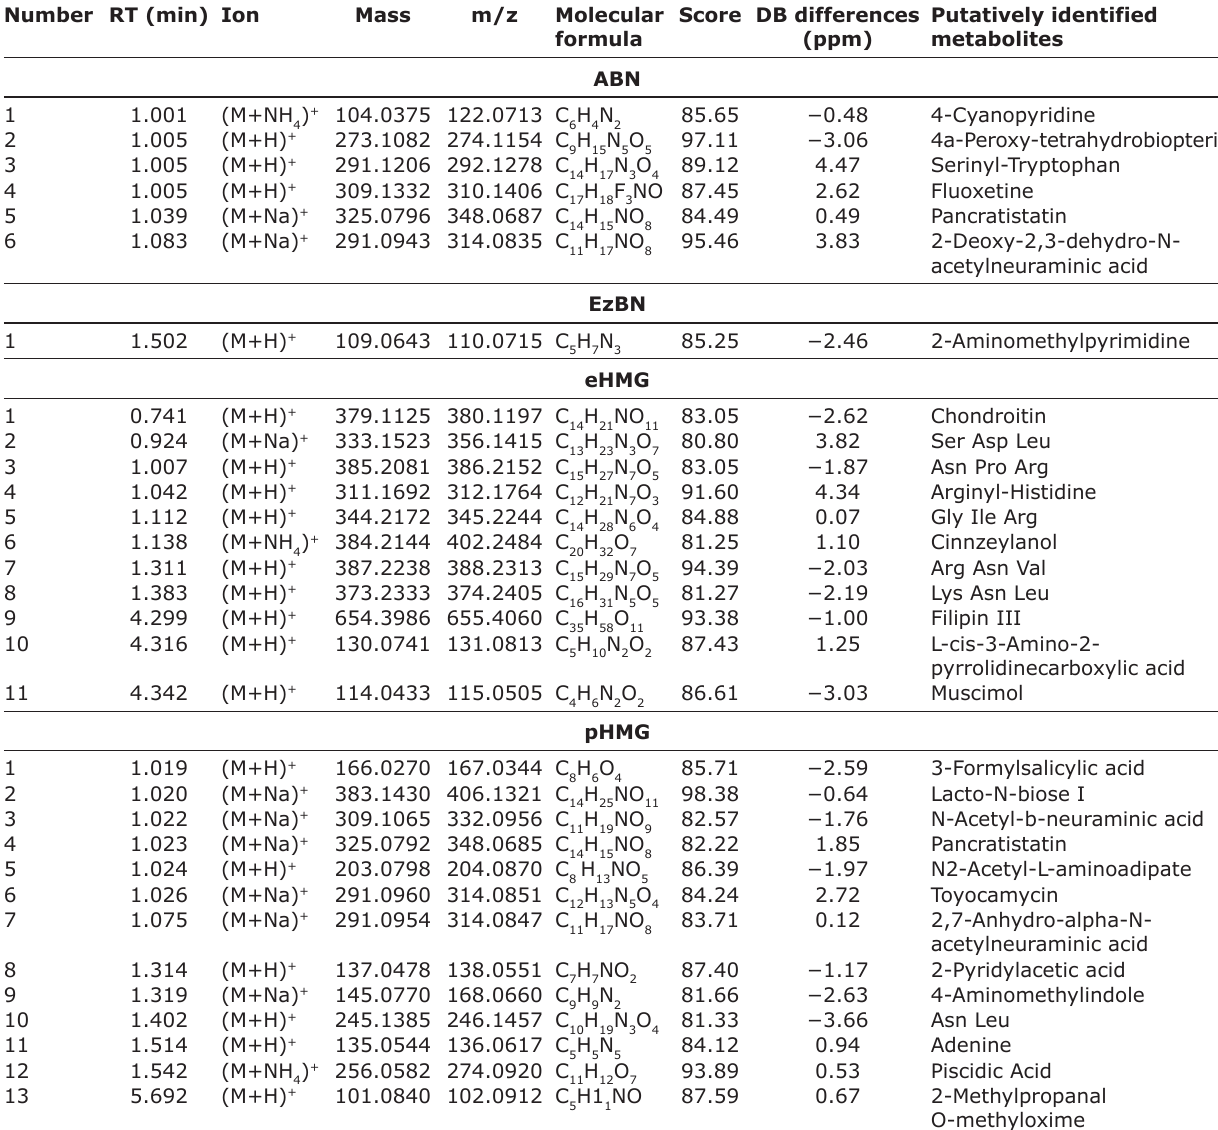
Table-1: Information of the metabolites in each extracts with first pre-screening by QTOF LC-MS. Number RT (min) Ion